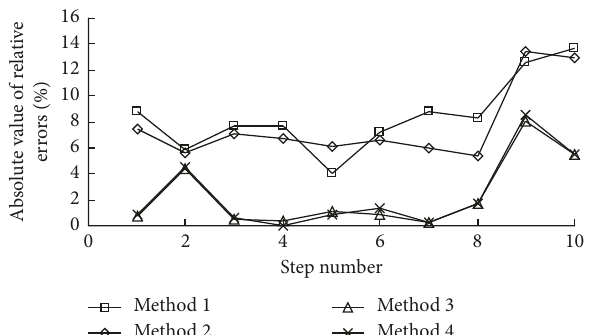
Figure 10: Generated data of X